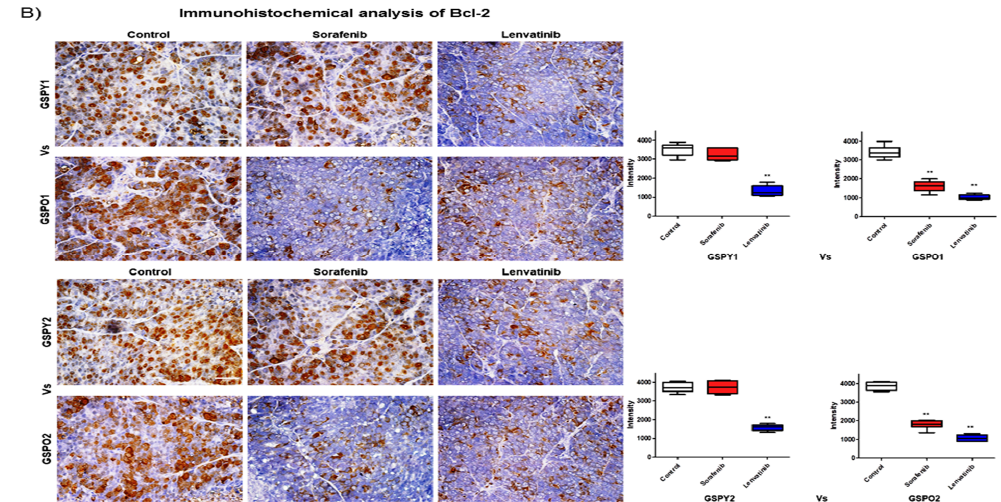
Figure 5. ( A ) Immunoblot analysis of FGFR signaling pathway, EMT, and anti-apoptotic-related proteins in tumor tissues derived from xenograft models using young (GSPY) and older (GSPO) patient-derived papillary thyroid cancer cells. ( B ) Immunohistochemical analysis of Bcl-2 protein levels in paraffin-embedded xenograft tumor tissues. Scale bar, 80 μm. Lenvatinib and sorafenib were administered orally (p.o.), once every 2 days and total lysates or paraffin-embedded were prepared from GSPY and GSPO xenograft model. The assay estimated the marker levels of FGFR signaling pathway (PKC, MEK and p-ERK1/2), EMT (Snail and Zeb1), and anti-apoptotic factor (Bcl-2) in GSPY and GSPO samples. * p < 0.05, ** p < 0.01, and *** p < 0.005 compared with the control.